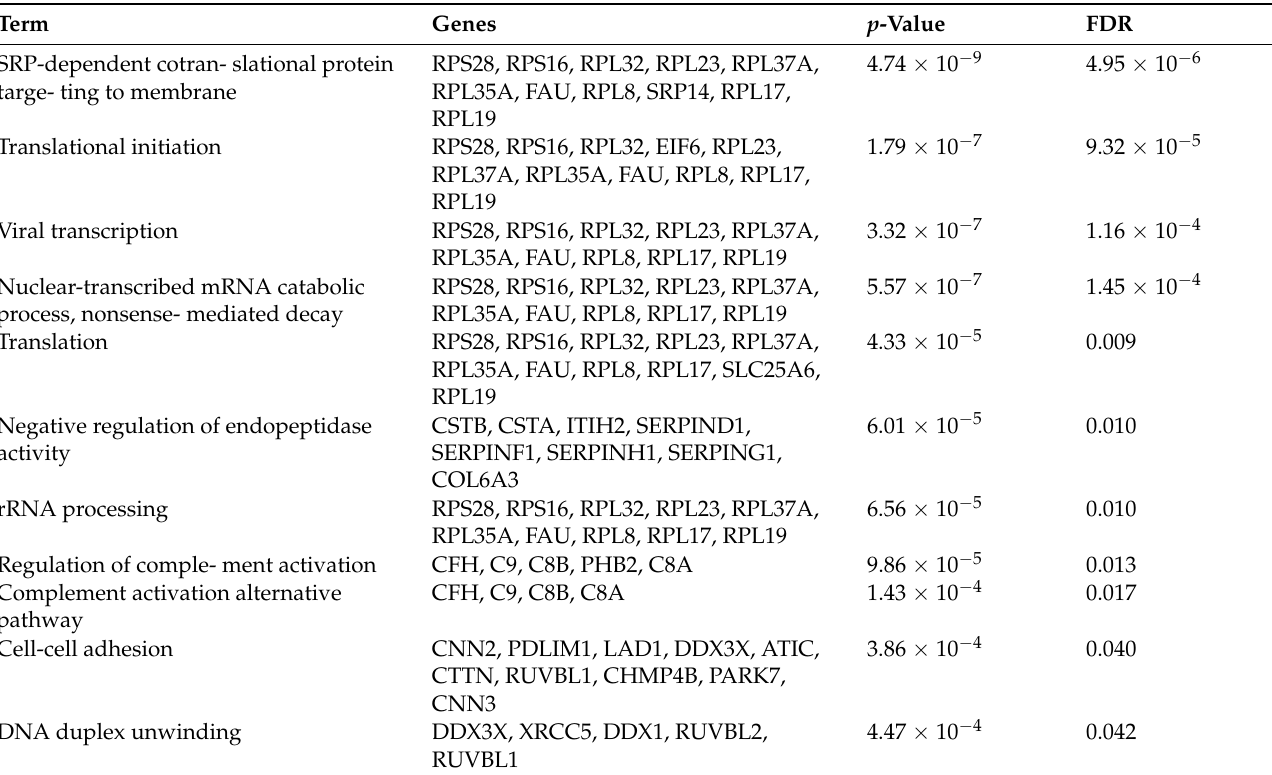
Table 5. The ontology analysis of proteins differentially expressed in male lesional and uninvolved skin. The analyzed proteins were differentially expressed in male lesional and uninvolved skin and were not differentially expressed in female lesional and uninvolved skin compared to the skin of healthy